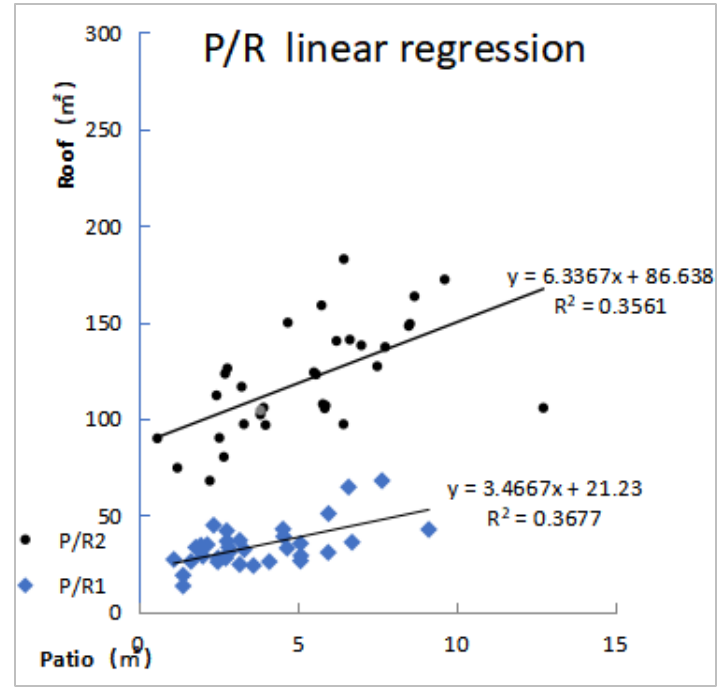
Figure 3. The linear regression of roof and patio surface areas of the two villages This is in line with the design language patterns of traditional Chinese architecture;